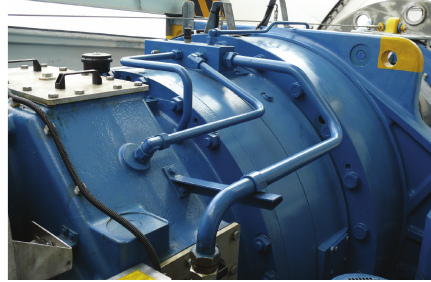
Figure 1: Planetary